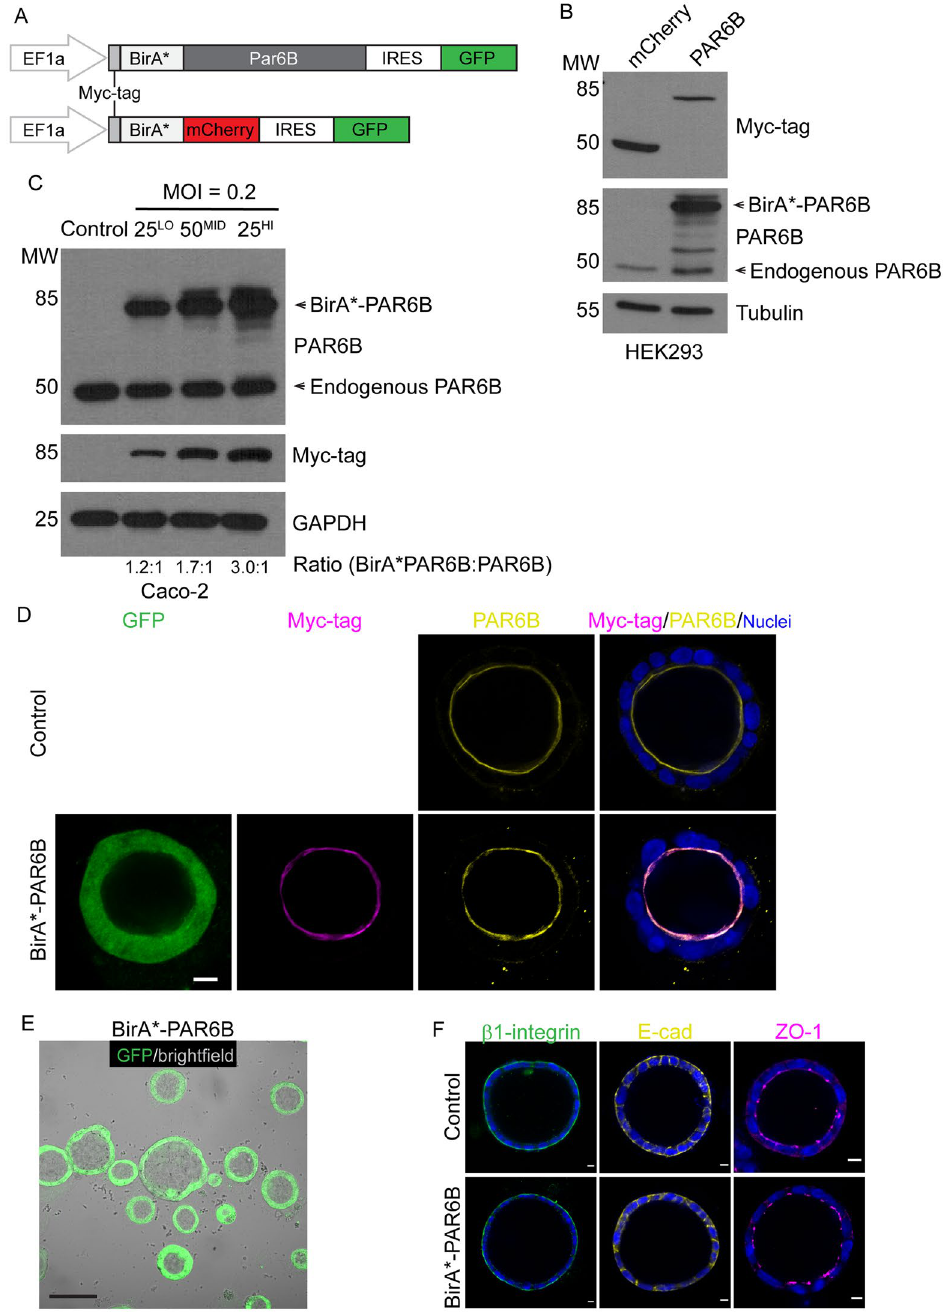
Figure 2. Validation of BirA*-PAR6B expression and localization. ( A ) Schematic showing lentiviral constructs for the expression of BirA*PAR6B and BirA*-mCherry. Expression was driven by an EF1α promoter, and an internal ribosomal entry site (IRES) directs expression of GFP. ( B ) Myc-tagged BirA*-mCherry (control) and BirA*-PAR6B expression were confirmed in HEK293 cells by western blot analysis. ( C ) To provide consistent expression levels, Caco-2 cells were infected with lentiviral constructs shown in (A) at a low multiplicity of infection (MOI = 0.2) to ensure single site integration. Three levels of expression were isolated by FACS of the coupled GFP marker: lowest 25%, the middle 50%, and the highest 25%. The expression of BirA*-PAR6B was determined by western blot with PAR6B antibodies. The ratio of BirA*-PAR6B: endogenous PAR6B is denoted at the bottom of the blot. ( D ) Confocal images were captured for control (uninfected) and BirA*-PAR6B- expressing 3D Caco-2 cells, immunostained for myc-tag (magenta) and PAR6B (yellow), to demonstrate that BirA*-PAR6B localizes to the apical membrane. GFP was visualized by direct fluorescence. ( E ) Widefield images (brightfield and GFP fluorescence) were captured and overlaid, demonstrating that BirA*-PAR6B-expressing 3D Caco-2 cells form a single prominent lumen. ( F ) Confocal images were captured for control (uninfected) and BirA*-PAR6B-expressing 3D Caco-2 cells, immunostained for β1-integrin (green), E-cad (yellow), and ZO1 (magenta), to demonstrate that basal, lateral, and apical markers are properly localized. Scale Bars: D, F, 10 µm; E, 100